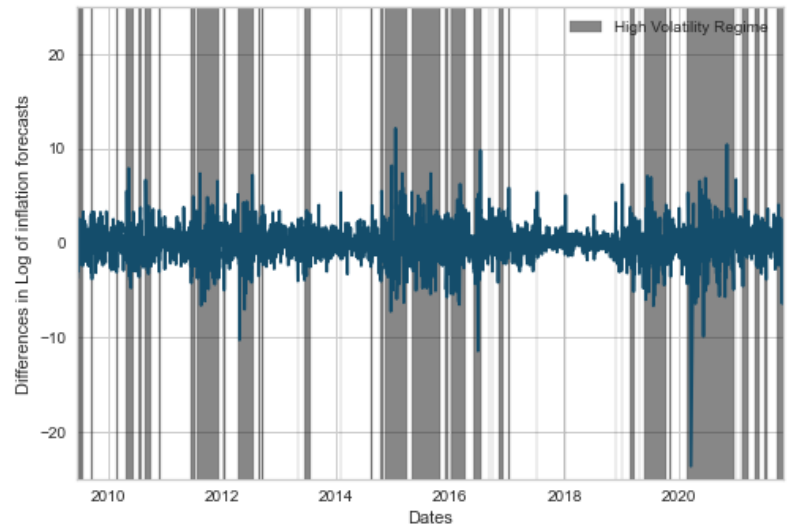
Figure 1. Implied inflation changes through volatility